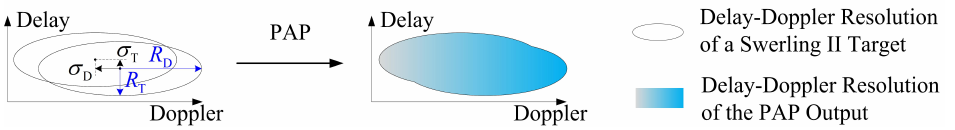
Figure 5. The location uncertainties of a Swerling II target to the decrease of Delay-Doppler resolution after